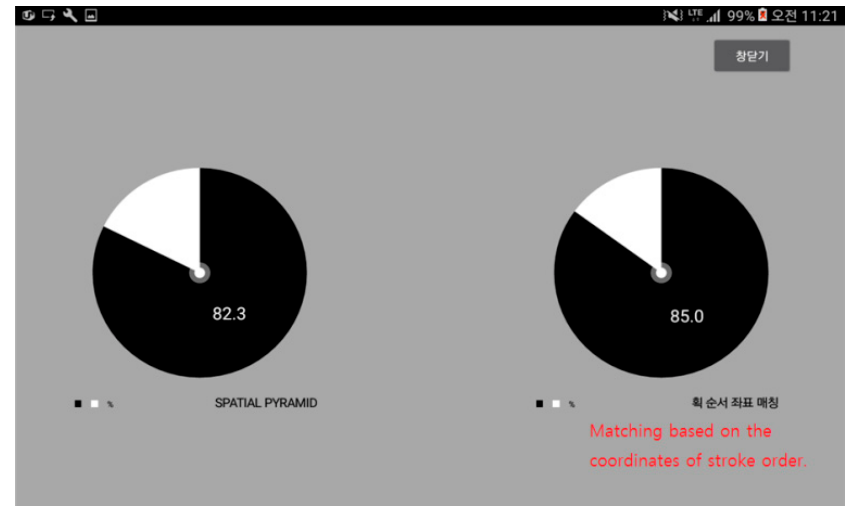
Figure 12. Result of Spatial Pyramid Matching.